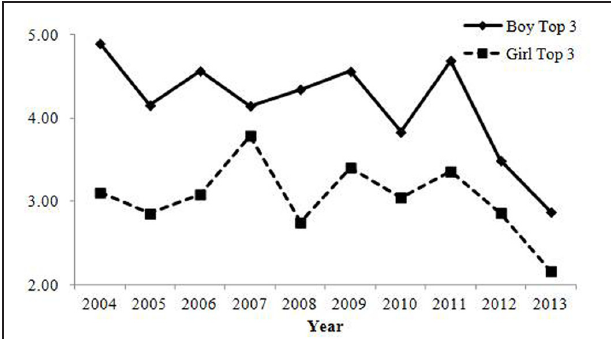
FIGURE 6 | Square average variations of written forms for names with one of the top 3 most common pronunciations in Study 2. Variations of written form decreased over time for both in boys’ and girls’